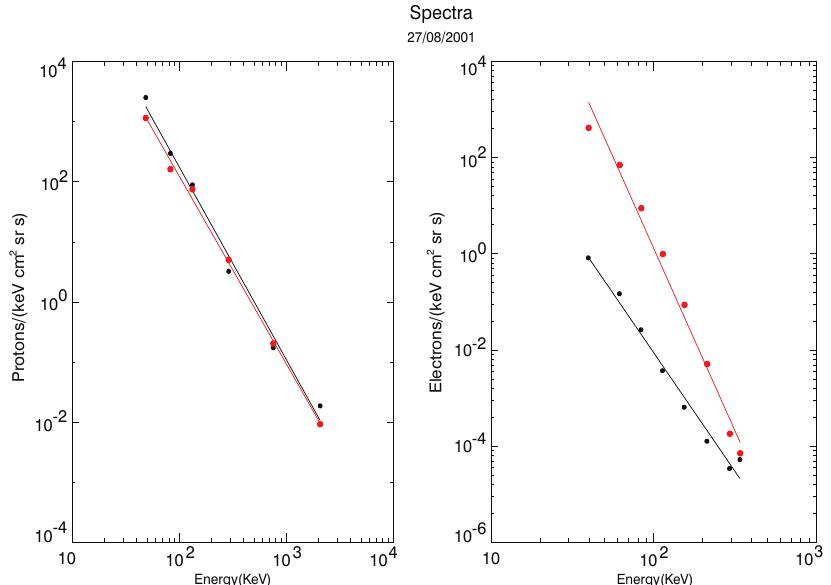
Fig. 11. Representative proton and electron energy spectra from S/C 1 for the intervals 04:00–04:05 UT (black color-coded) and 04:30- 04:35 UT (red color-coded) during which the Cluster spacecraft were inside the plasma sheet (see panels (g) and (h) in Fig. 3). Also shown are the calculated best fits for the flux versus energy points. Unlike protons, electrons show a clear softening of their spectrum which is attributed to an additional electron source at lower